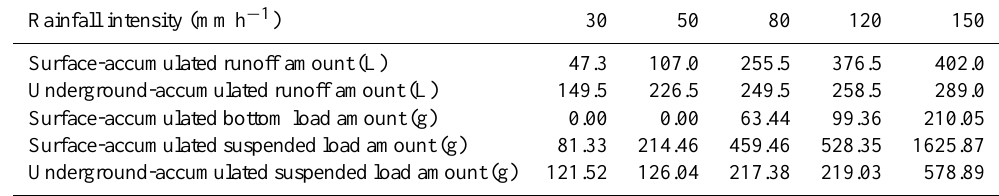
Table 2. Rainfall intensity on the impact of runoff and sediment production.